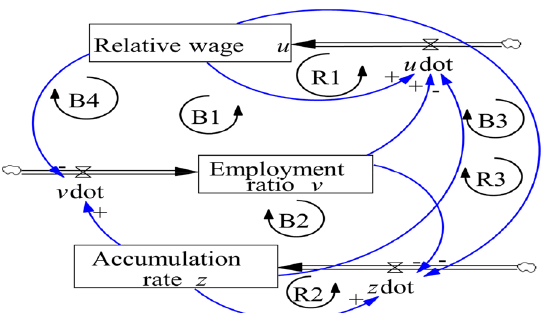
Fig. 6 A condensed stock-and-flow diagram of L-1 at E b (30) undergoing the first AHB; a total number of feedback loops is 7: first order—2 (positive), second order—3 (2—negative, 1—positive), third order—2 (2—